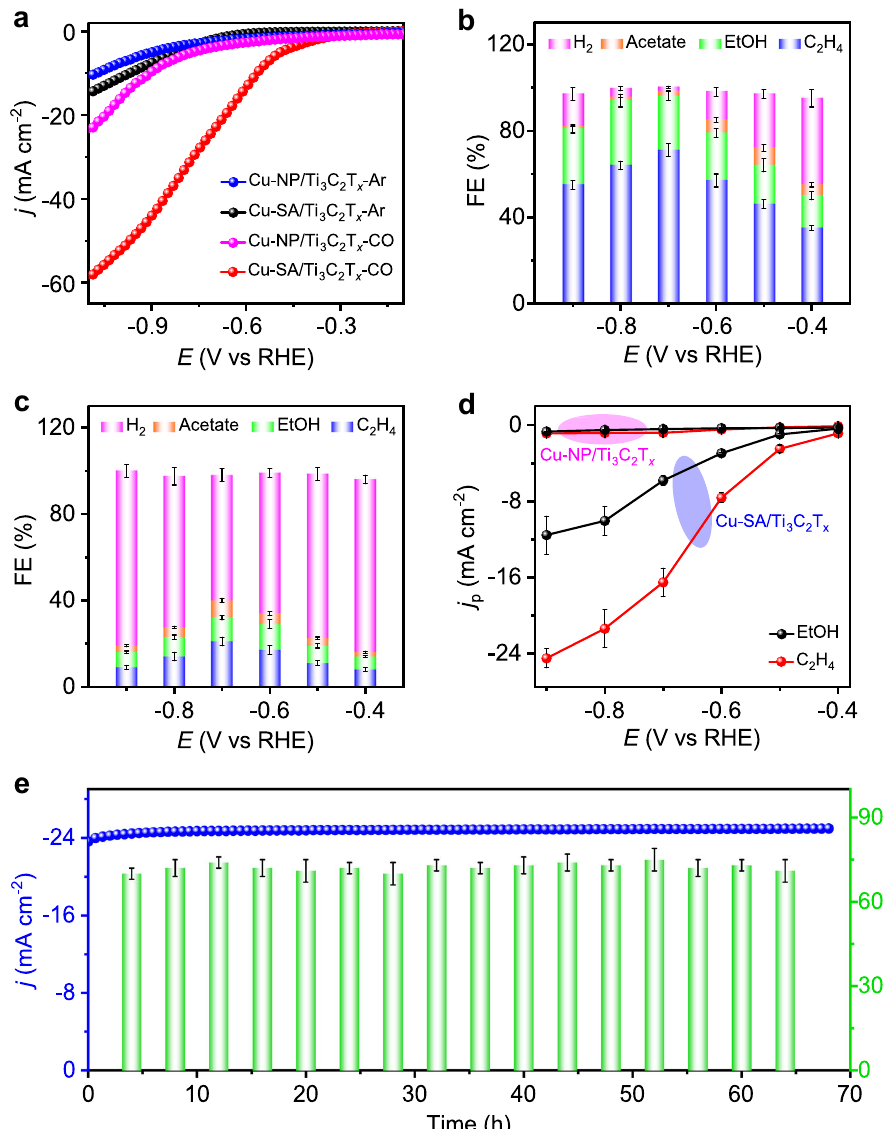
Fig. 2 Electrochemical CO reduction performances. a Linear sweep voltammetry curves of Cu-SA/Ti 3 C 2 T x measured in CO- or Ar-saturated 1 M KOH solution at a scan rate of 10 mV s − 1 ; potentials have been i R-corrected. b , c Faradaic ef fi ciencies (FE) toward H 2 and CO reduction products (C 2 H 4 , EtOH, and acetate) of b Cu-SA/Ti 3 C 2 T x and c Cu-NP/Ti 3 C 2 T x at various applied potentials for 2 h. d The partial current densities ( j p ) of C 2 H 4 and EtOH at test potentials. e Chronoamperometry test and FE of C 2 H 4 for Cu-SA/Ti 3 C 2 T x at an applied constant potential of – 0.7 V vs RHE for 68 h. The error bars correspond to the standard deviations of measurements over three separately prepared samples under the same testing